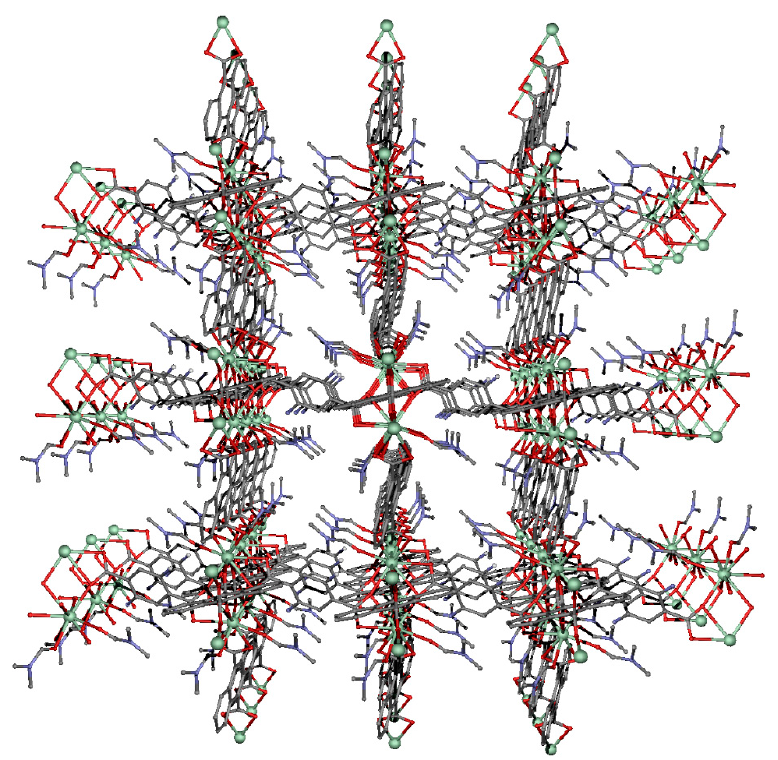
Figure 2. View along the c -axis of the channels in compound 1 . DMF solvent molecules and hydro- gen atoms have been omitted for clarity. atoms have been omitted for